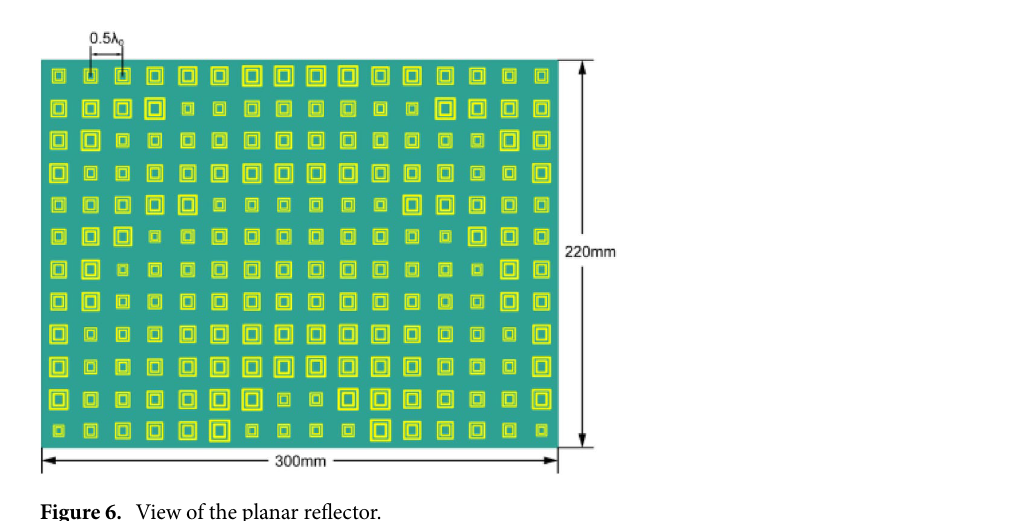
Figure 5. Current distributions on the proposed reflectarray antenna: (a) rejected design; (b) final design.